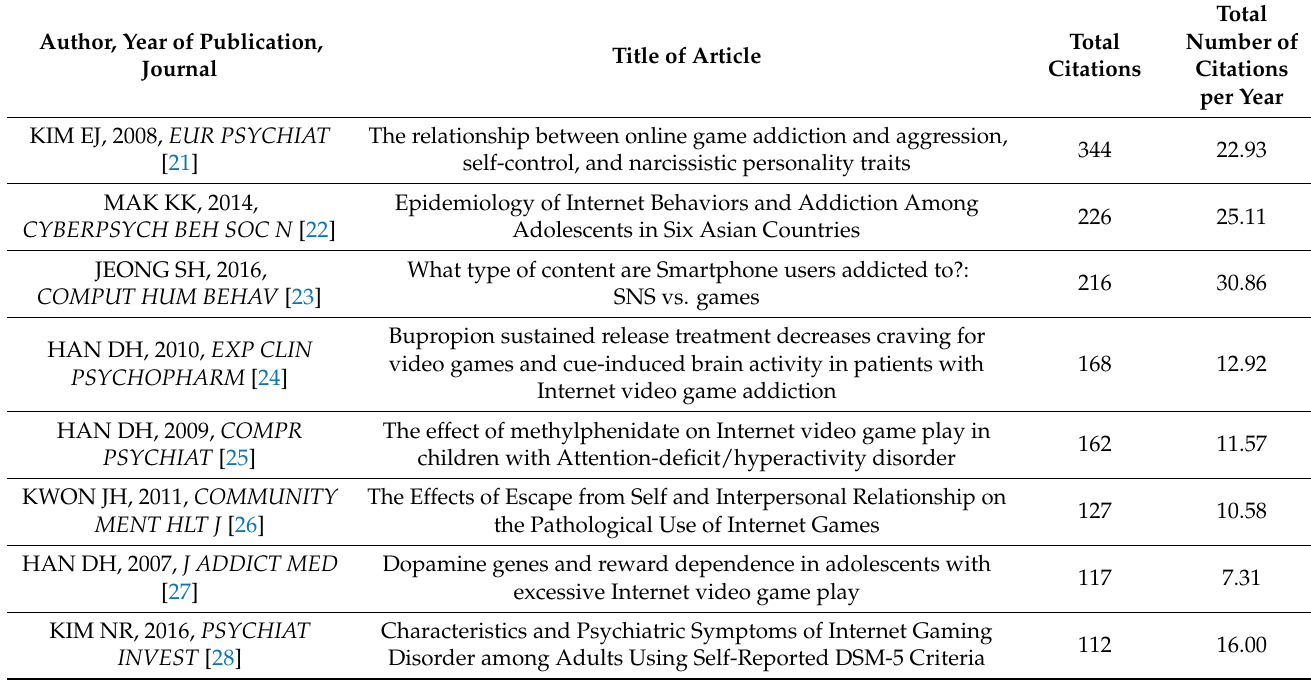
Table 3. Overview of the top 20 most cited